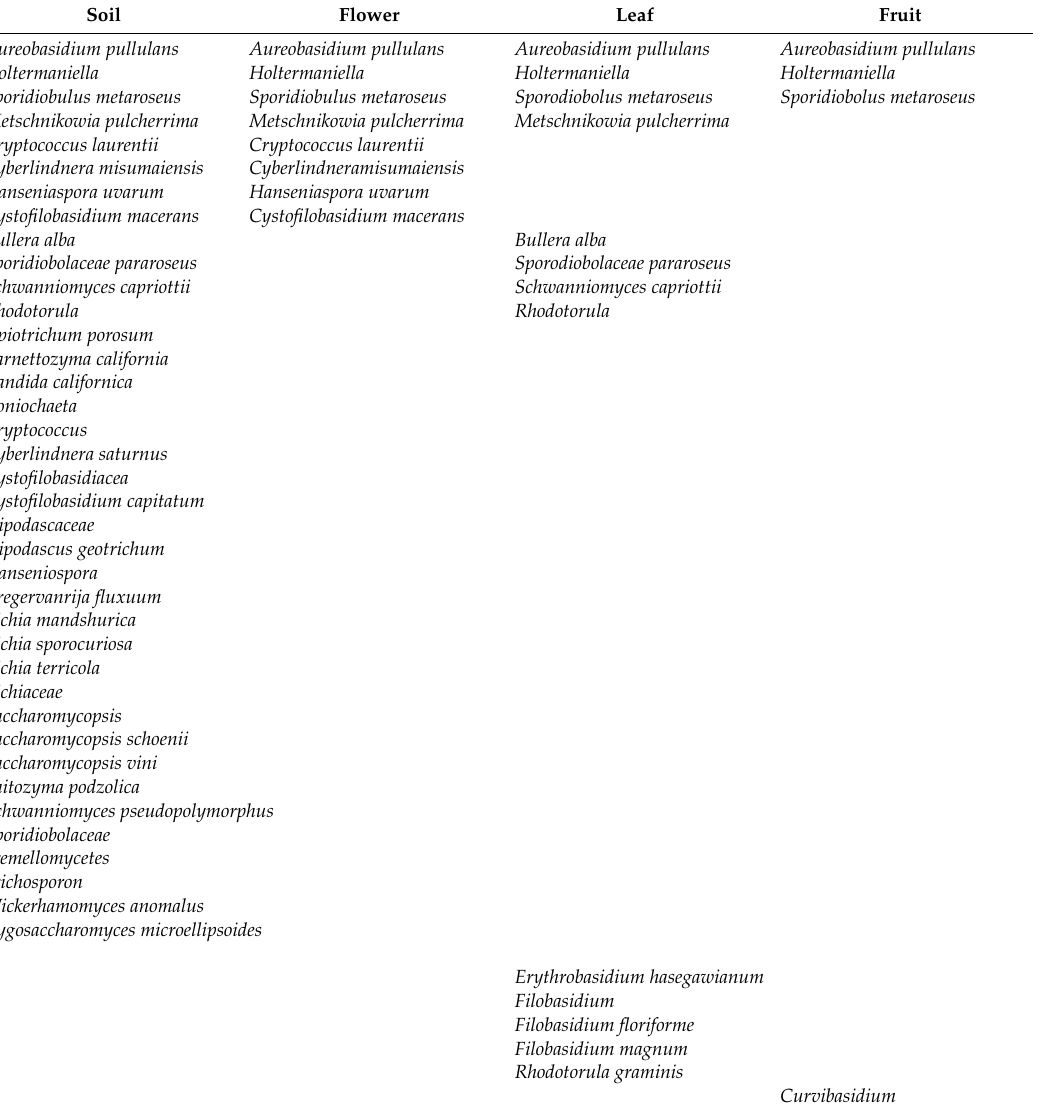
Table 1. Yeast species isolated from soil, flower, leaf, and fruit samples in this study. A. pullulans, Holtermaniella, and S. metaroseus were isolated from all sample types. The species were identified by MALDI-TOF mass spectrometry (MS) as a fast and economical alternative to DNA sequencing. Isolates that could not be identified by MALDI-TOF MS were determined based on the ITS sequence. Those identified by the ITS sequence were assigned species hypotheses (SH numbers) [32,33].